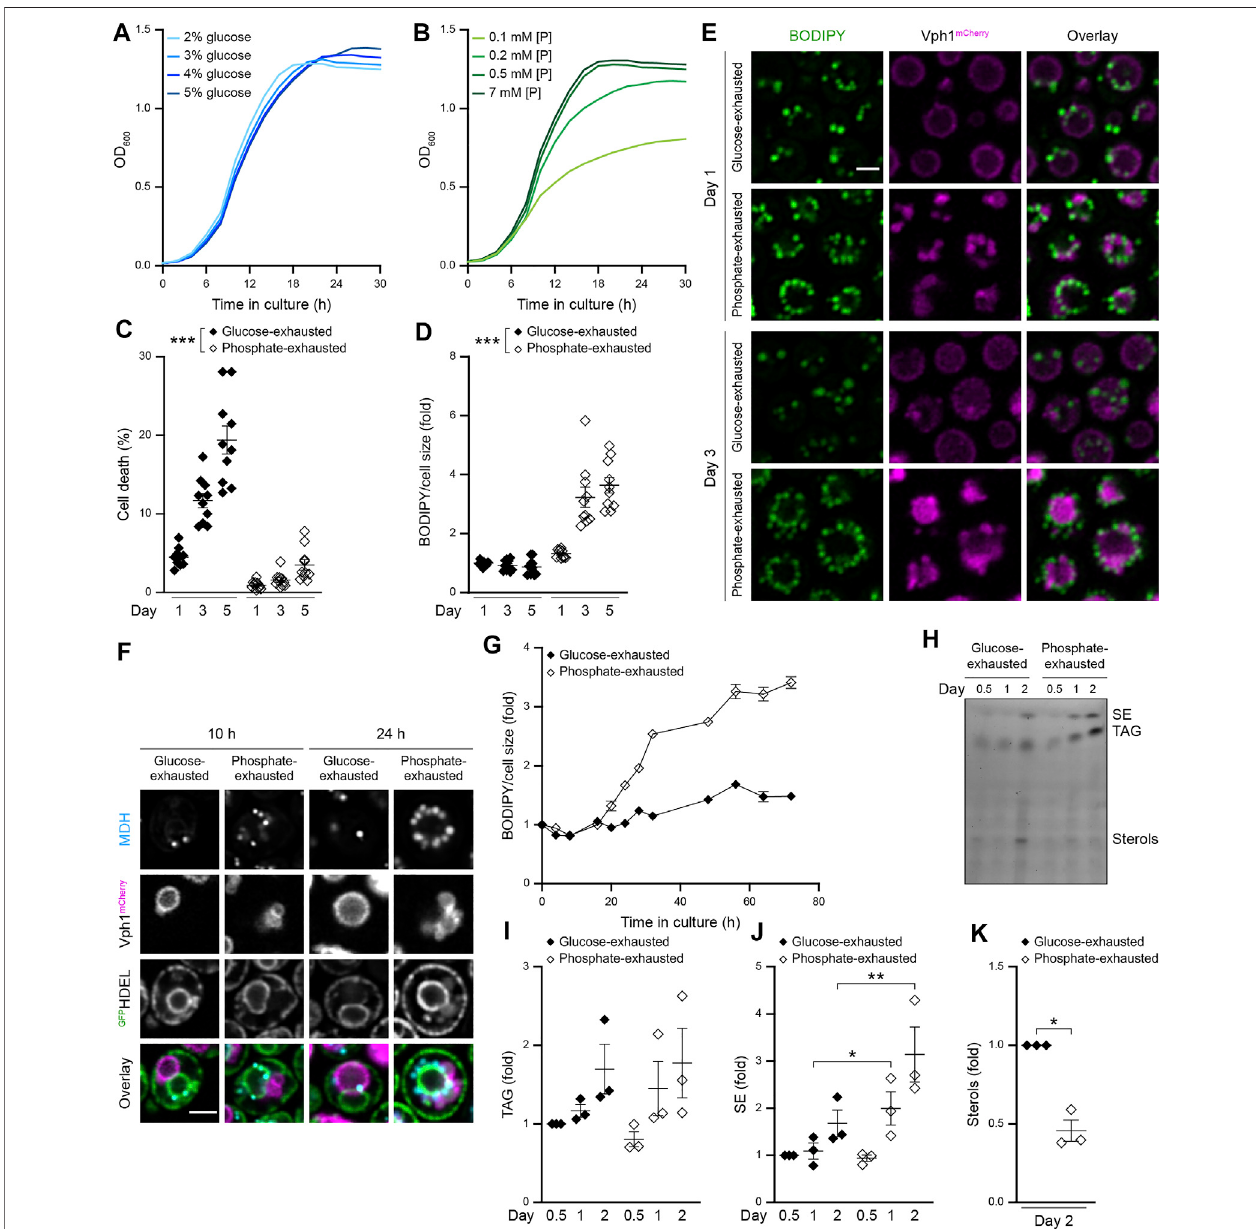
FIGURE 1 | Gradual phosphate exhaustion drives LD biogenesis (A,B) Growth kinetics of wild type (WT; BY4742 unless stated otherwise) cells grown in media containing indicated glucose (A) or phosphate (B) concentrations. OD 600 was recorded every 2 h; n = 8 (C) Cell death determined by fl ow cytometric quanti fi cation of propidium iodide staining of WT cells grown into phosphate or glucose exhaustion. Mean ± SEM; n = 10 (D) Flow cytometric quanti fi cation of neutral lipid content via BODIPY-stainingofWTcells grownintophosphate orglucose exhaustion. BODIPYmean fl uorescenceintensitywasnormalizedtorespectivecellsize, anddatais shown as fold of glucose-exhausted cells at day 1. Mean ± SEM; n = 10 (E) Confocal micrographs of WT cells stained with BODIPY to asses LD localization and harboring endogenously mCherry-tagged Vph1 to visualize vacuoles, subjected to glucose or phosphate exhaustion for indicated time. Scale bar: 2 μ m (F) Confocal micrographs of WT (BY4741) cells endogenously expressing Vph1 mCherry and a soluble ERreporter (preKar2- GFP HDEL) to visualize vacuolesand ER, respectively. Cells were subjected to monodansylpentane (MDH) staining to visualize LDs after 10 and 24 h of growth into glucose or phosphate exhaustion. Micrographs of glucose- exhausted and phosphate-exhausted cells were processed differently to avoid oversaturation of the signals. Scale bar: 2 μ m (G) Flow cytometric quanti fi cation of LD biogenesis during growth of WT cells into glucose or phosphate exhaustion. Cells were stained with BODIPY at indicated time points and values were normalized to respective cell size. Data is shown as fold of glucose-exhausted cells upon inoculation. Mean ± SEM; n = 6 – 12 (H) Thin-layer chromatography to assess neutral lipid contentinlipidextractsfromWTcellsgrownintoglucoseorphosphateexhaustionforindicatedtime (I,J) Densitometricquanti fi cationofTAG(I)andSE(J)contentusing thin-layer chromatography as shown in (H). Values were normalized to TAG or SE content after 12 h (0.5 days) of growth. Mean ± SEM; n = 3 (K) Densitometric quanti fi cation offreesterols inlipid extracts from cellssubjectedtoglucose or phosphate exhaustion for2 days using thin-layerchromatography asshown in (H).Values were normalized to glucose-exhausted cells. Mean ± SEM; n = 3. For more details in respect to statistical analyses, please see Supplementary Table S4 .